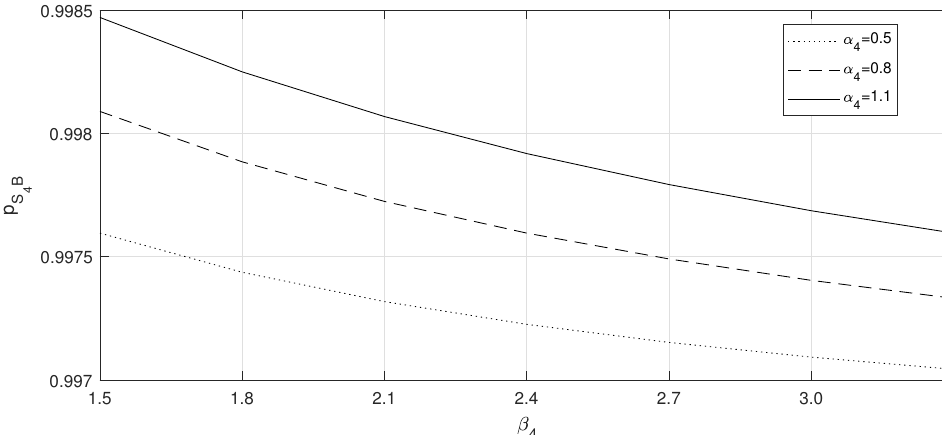
Figure 12. Probability that Server-4 is busy on α 4 vs. β 4 .